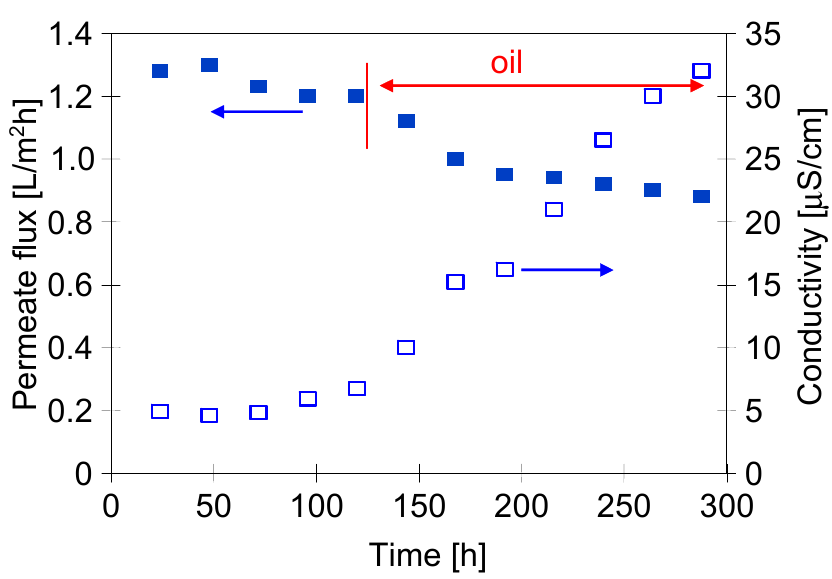
Figure 5. Changes of the permeate flux and distillate conductivity during operation of MDC system. Feed: saturated NaCl solutions contaminated with oil (82 mg/L). Temperature T F = 333 K and T C = 318 K. Module M2—membrane V8.